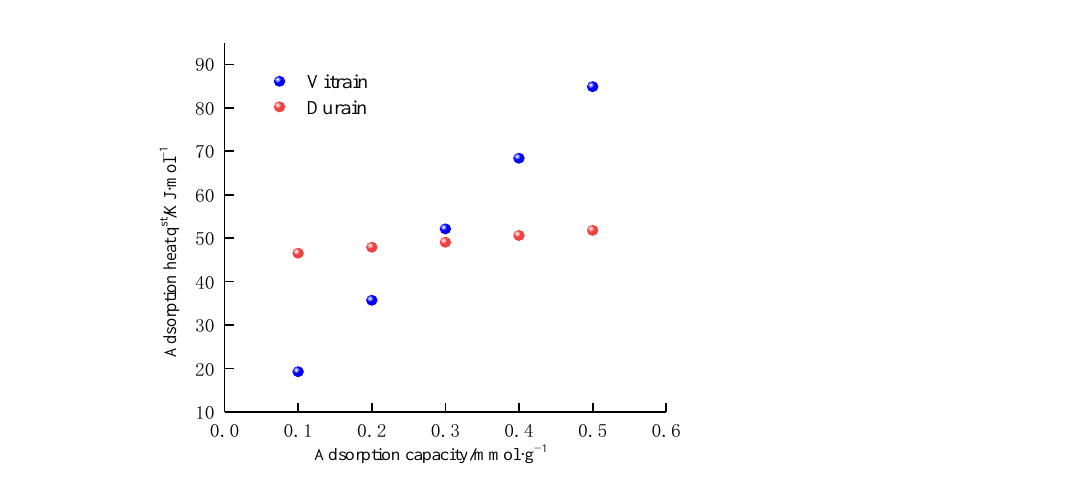
(b) Figure 9. ln f -T −1 of adsorption process in the desorption experimental : ( a ) vitrain; ( b ) durain. Table 10. Isosteric adsorption heat during methane desorption. Adsorbing Capacity/mmol·g −1